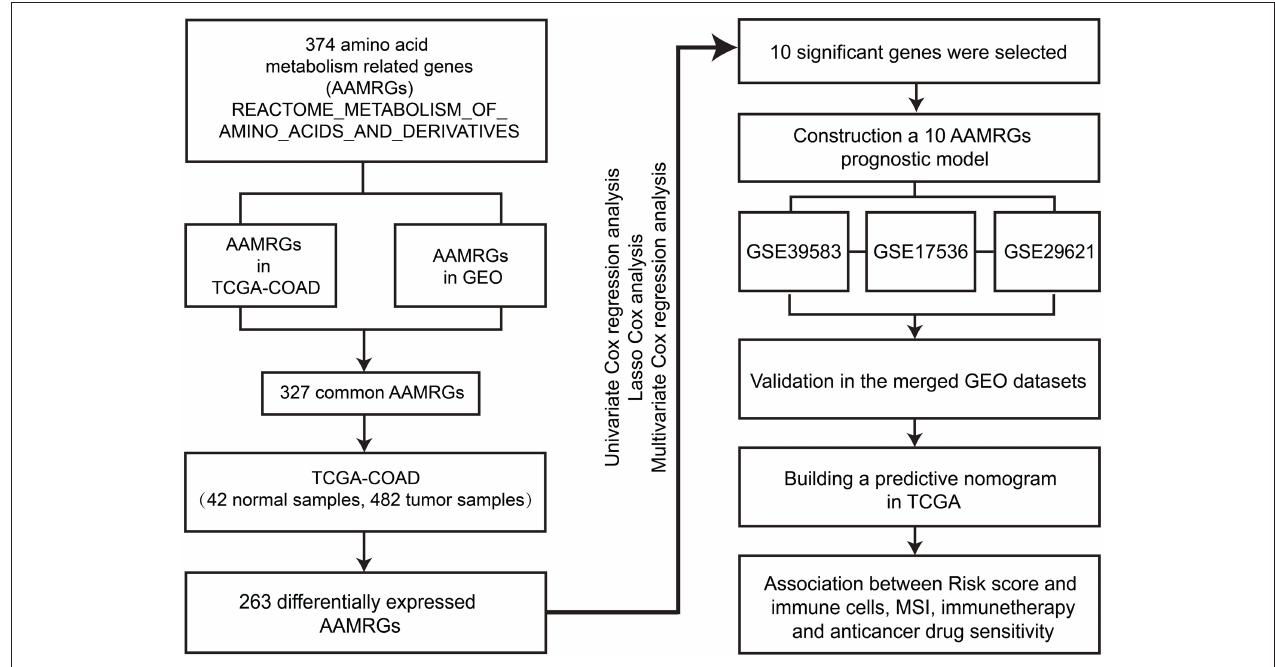
FIGURE 1 | The workflow of the